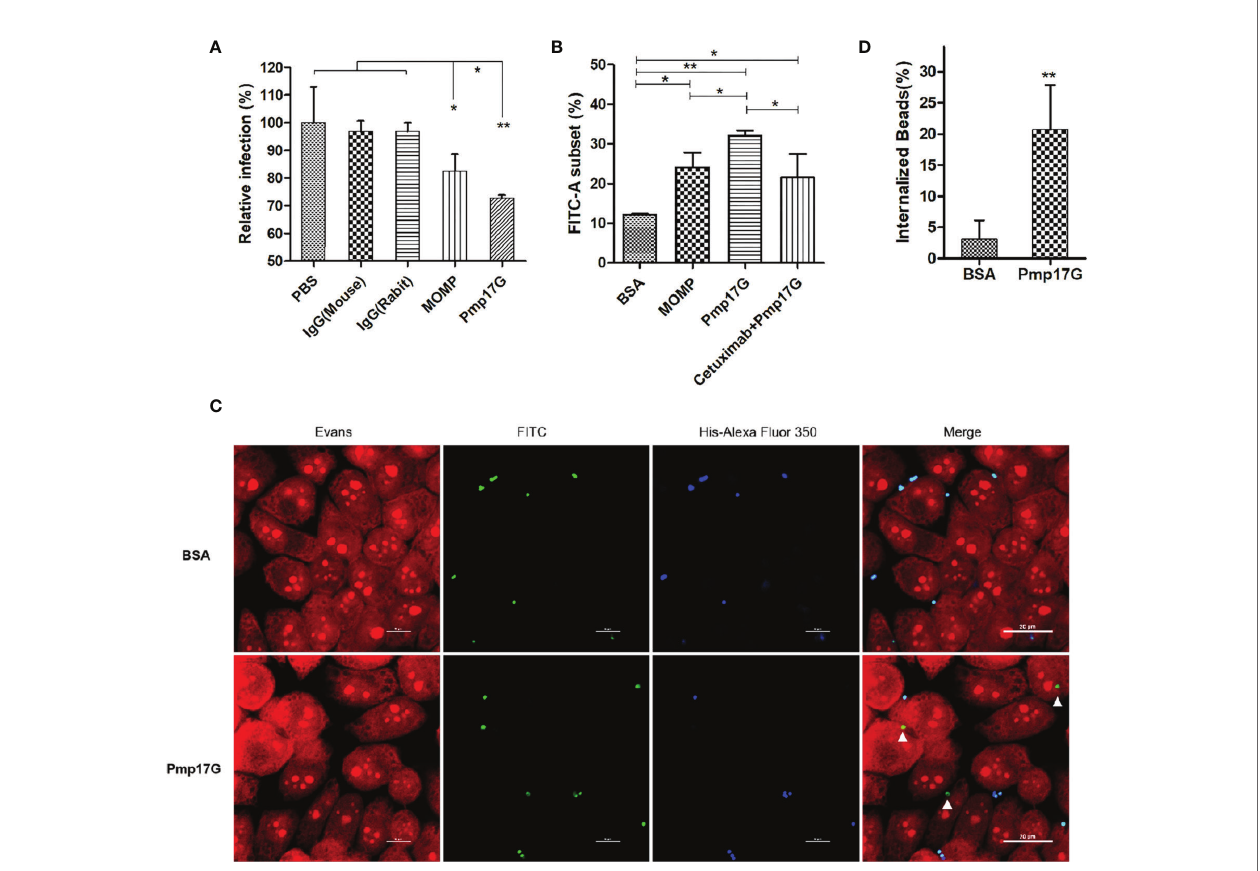
FIGURE 5 | Pmp17G contributed to adhesion and invasion during C. psittaci infection. (A) C. psittaci 6BC was treated with anti-Pmp17G antibody or anti-MOMP antibody while IgG(mouse), IgG(rabbit) and PBS were control groups. Then, HeLa 229 cells were infected with these preparations for 36-48 h Relative infection (%)=(IFUs of the antibody-treated group/IFUs of control group) ×100. (B) Pmp17G adhesive capability to HeLa 229 cells. HeLa 229 cells were incubated with BSA-, MOMP- or Pmp17G-coated green fl uorescent beads for 2 h at 37°C. Then, cell cultures were treated with trypsin (non-EDTA) for 3 min and washed 3 times with PBS, and the cells were resuspended in PBS. Adhesion of FITC-A subsets was measured using fl ow cytometry and proportion of FITC-A subsets was determined by dividing the number of FITC-labelled cells by the total number of cells. Three replicates of each measurement were performed. (C) Pmp17G invasion capability into HeLa 229 cells. HeLa 229 cells were incubated with BSA-, or Pmp17G-coated green fl uorescent beads for 6 h at 37°C. Subsequently, the cell cultures were washed 5 times with PBS and fi xed with 0.4% paraformaldehyde. Later, the extracellular binding beads were stained with 6×His-tag antibody (blue). Internalized beads displayed green. Cell structures were stained with Evans blue (red). (D) Internalized bead(%)=(Numbers of internalized beads/all the binding beads) ×100. Statistical analysis was performed by one-way ANOVA, and the data were expressed as the means ± SD. Asterisks indicate statistical signi fi cance: *p < 0.05, and **p <